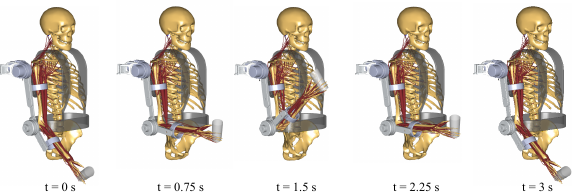
Figure 6: Simulation study of the human-exoskeleton system during the bicep